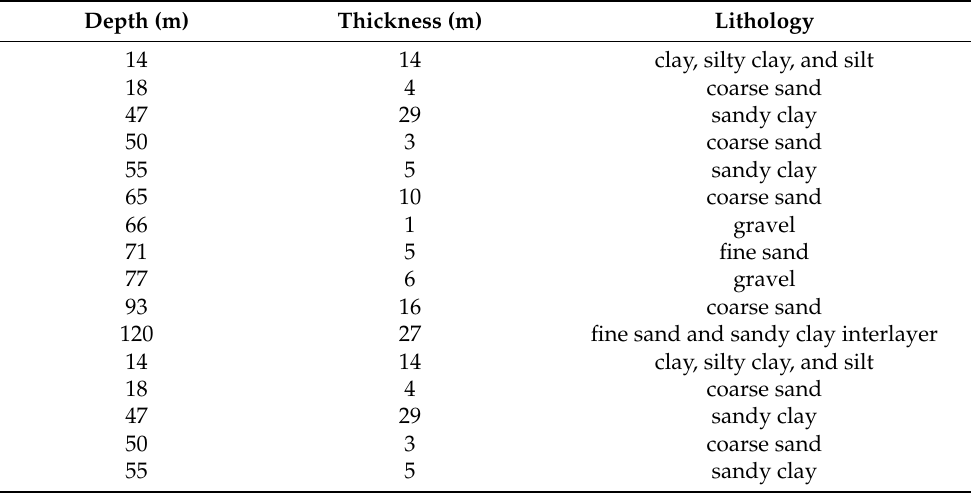
Table 4. The sedimentary sequence of rock formations of borehole SJZ-2. Depth (m) Thickness (m)